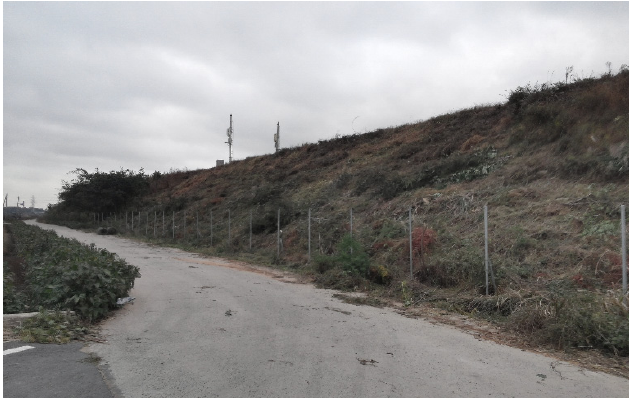
Figure 5. Differences in widening the embankment.